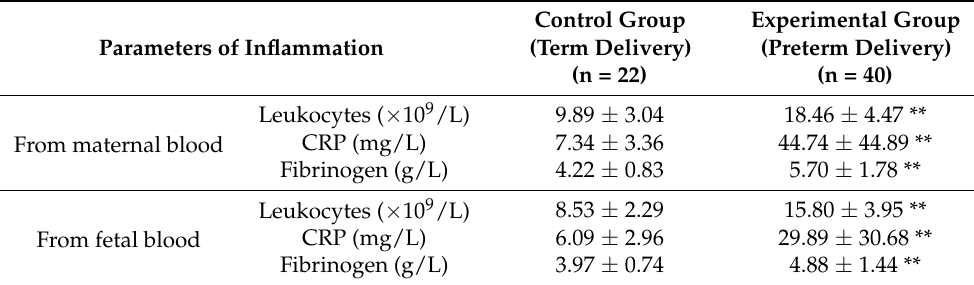
Table 2. Inflammation parameters which were determined from maternal systemic circulation and umbilical cord